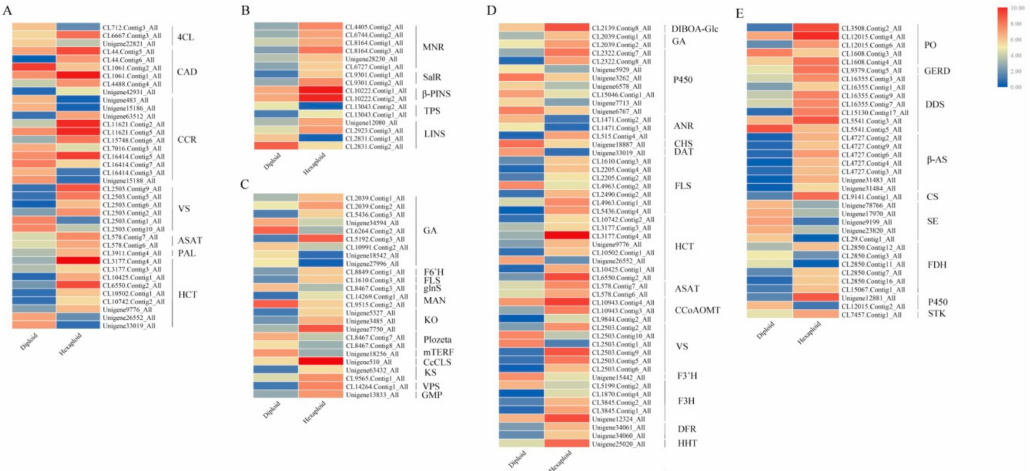
Figure 3. Expression profiles of enriched secondary metabolism synthesis related DEGs. The DEGs related to phenylpropanoid biosynthesis ( A ), monoterpenoid biosynthesis ( B ), diterpenoid biosynthesis ( C ), flavonoids biosynthesis ( D ), and sesquiterpenoid and triterpenoid biosynthesis ( E ) were depected. The color bar indicates the normalized relative expression levels; red indicates high expression level, blue indicates low expression